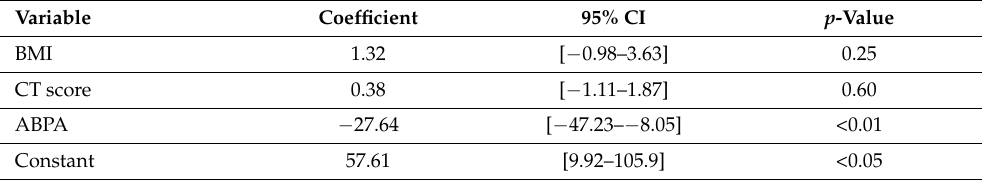
Table 3. Parameter estimates of the full linear mixed-effects regression model describing the associa- tions of FEV 1 percent predicted with BMI, CT score and ABPA.